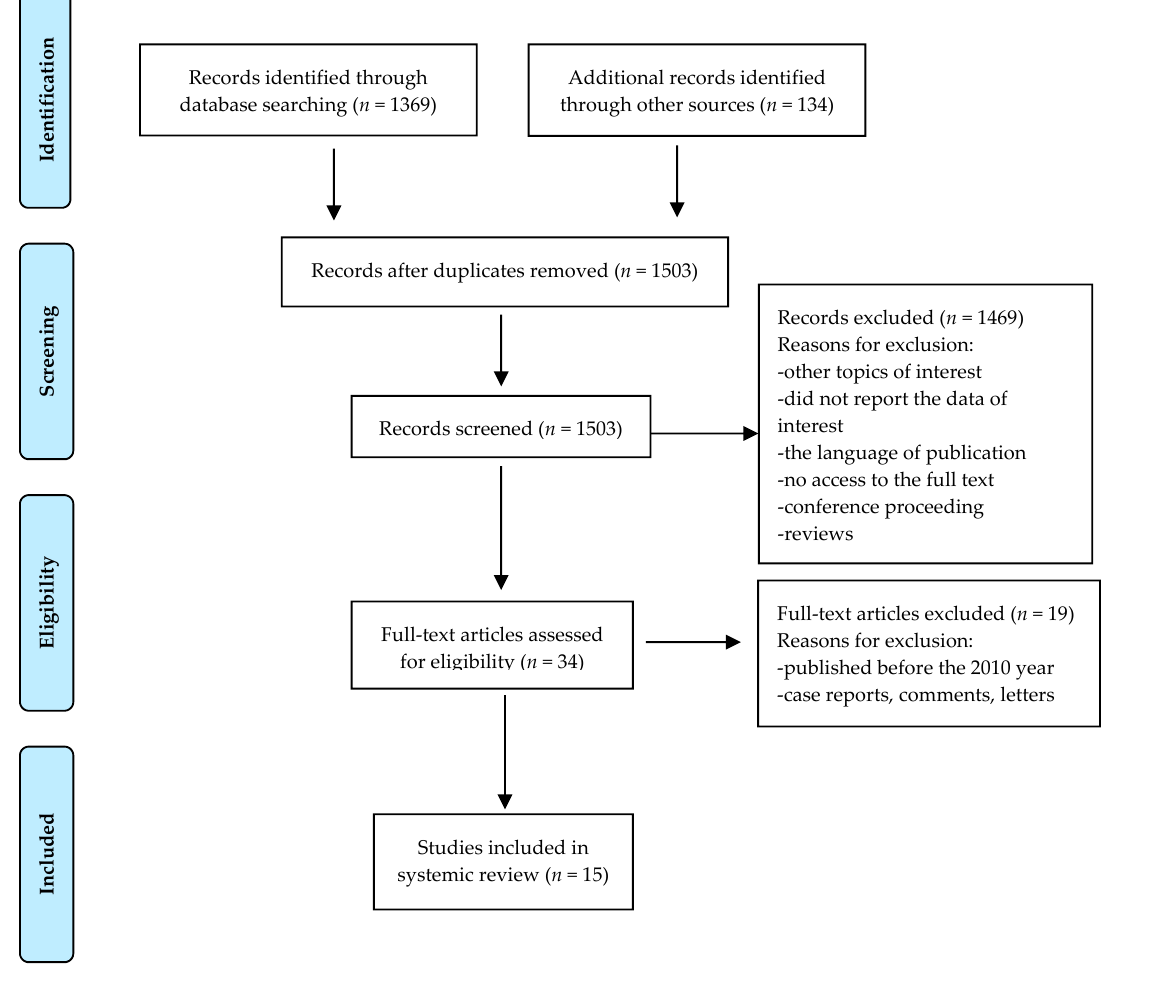
Figure 1. Flow diagram.